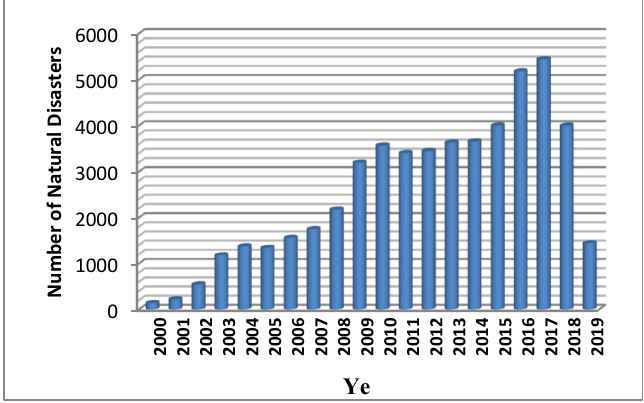
Fig. 1. Data on the Number of Natural Disasters in Indonesia